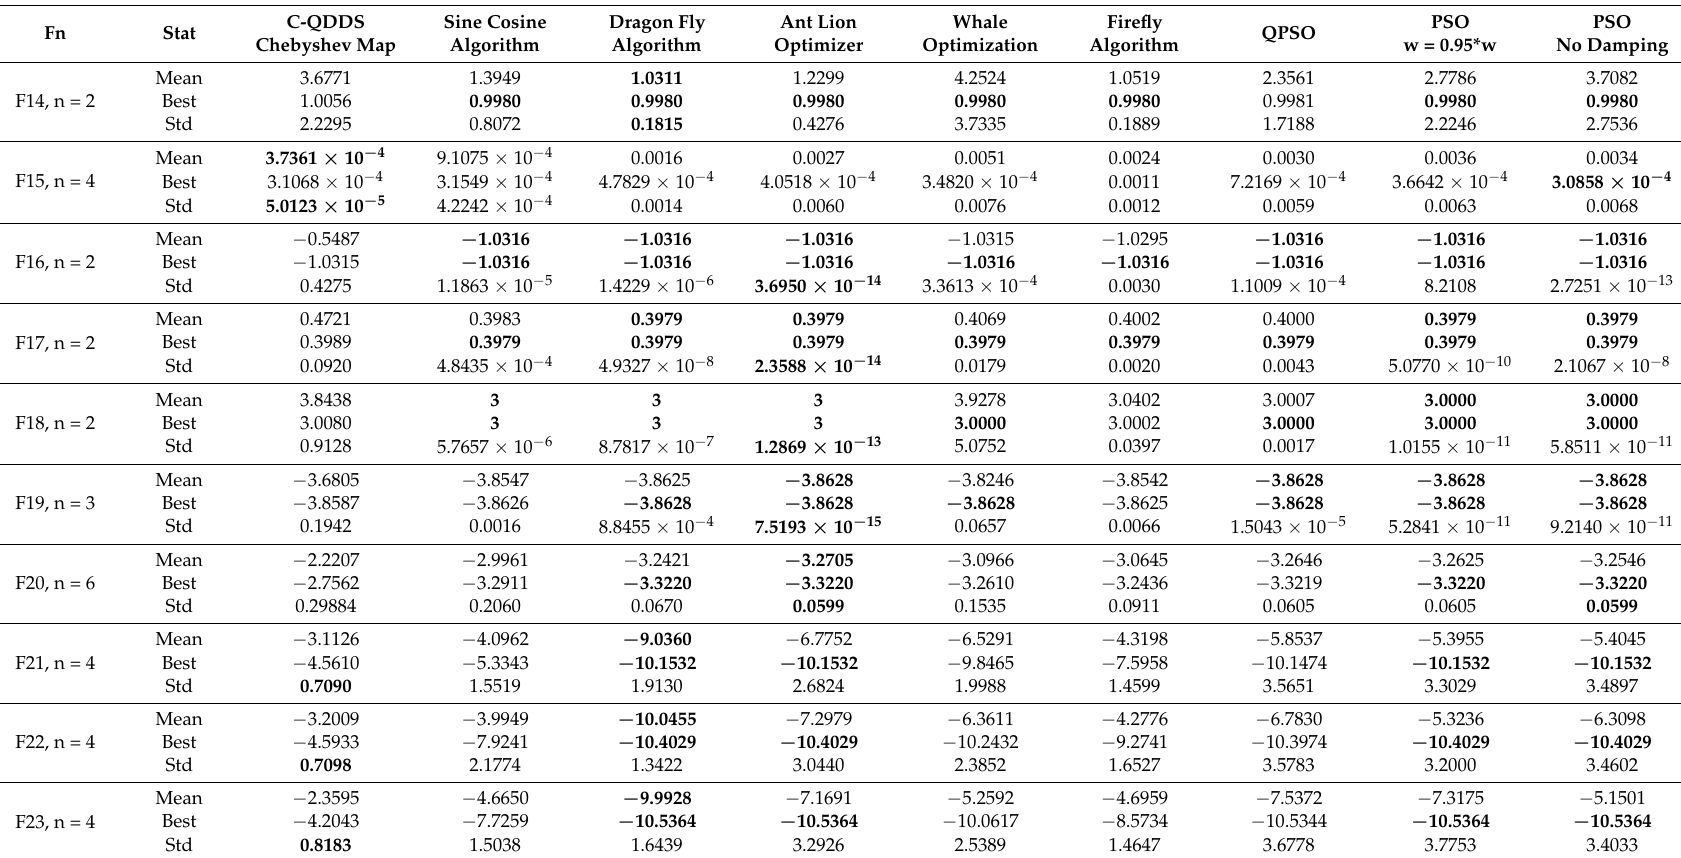
Table 12. Solution quality in multimodal functions in Table 4 (fixed dim, 1000 iterations, 30